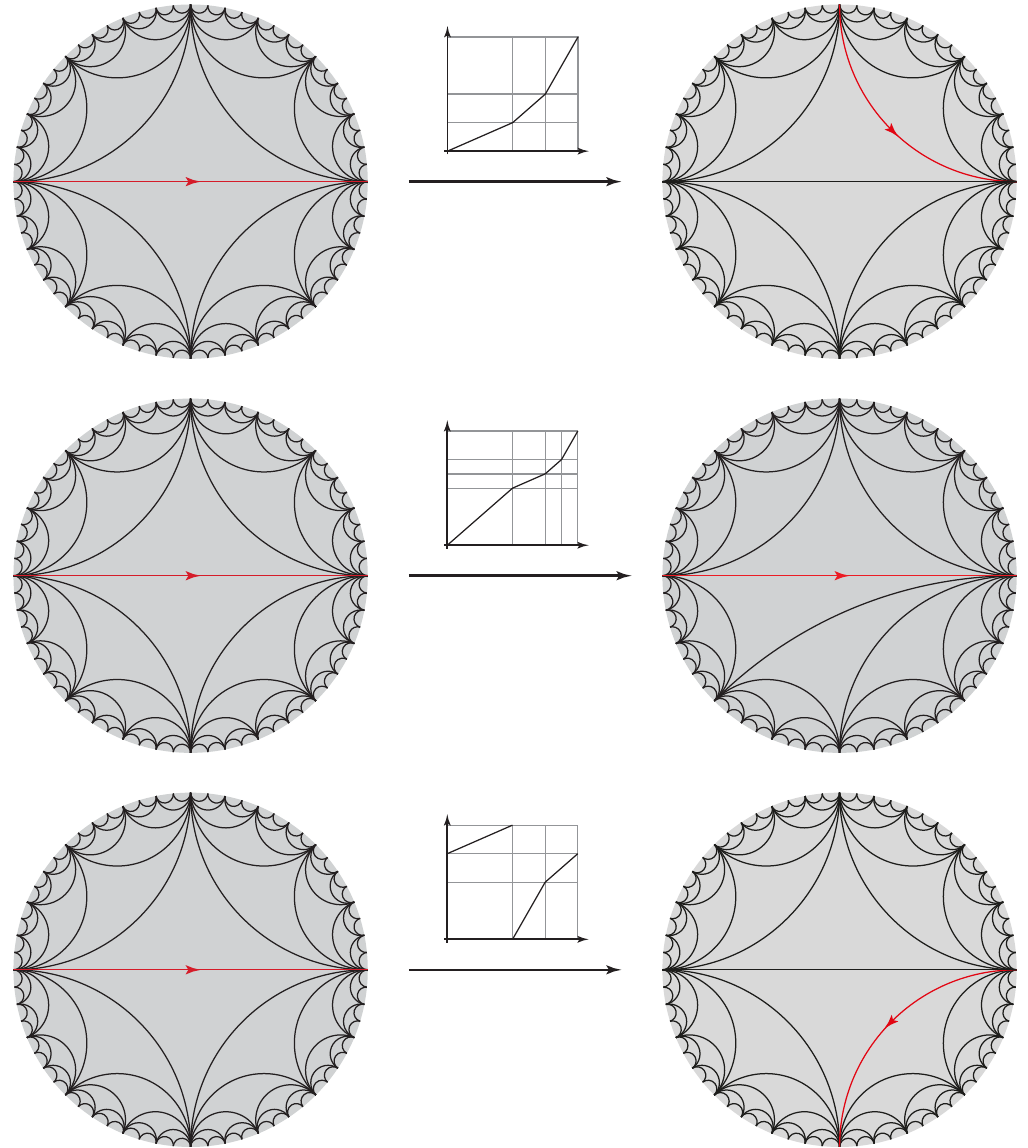
Figure 19 . The action of the three generators A , B , and C of Thompson’s group T on the standard dyadic